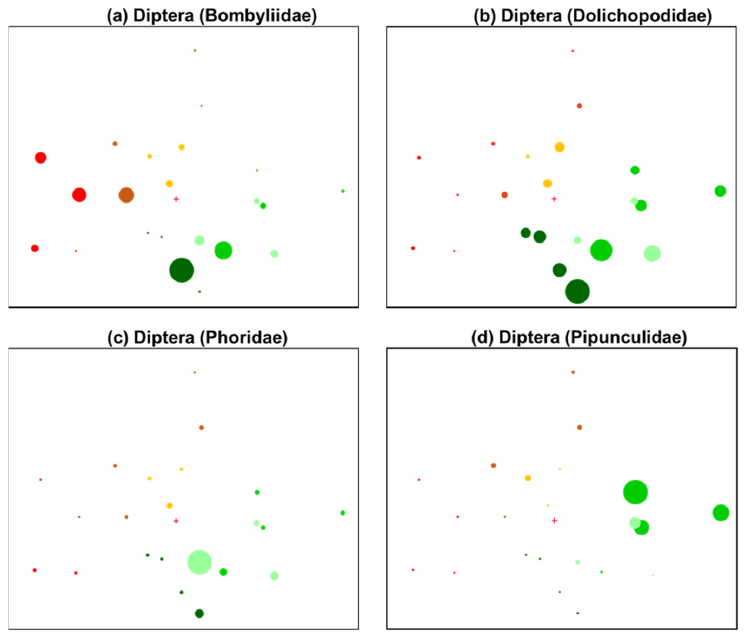
Figure 10. NMDS ordination results for negatively impacted Diptera in burn study sites. Panels ( a – d ) show results for Diptera Families; ( a ) Bombyliidae, ( b ) Dolichopodidae, ( c ) Phoridae, ( d ) Pipunculidae. Symbol size is scaled by percent abundance within each sample.